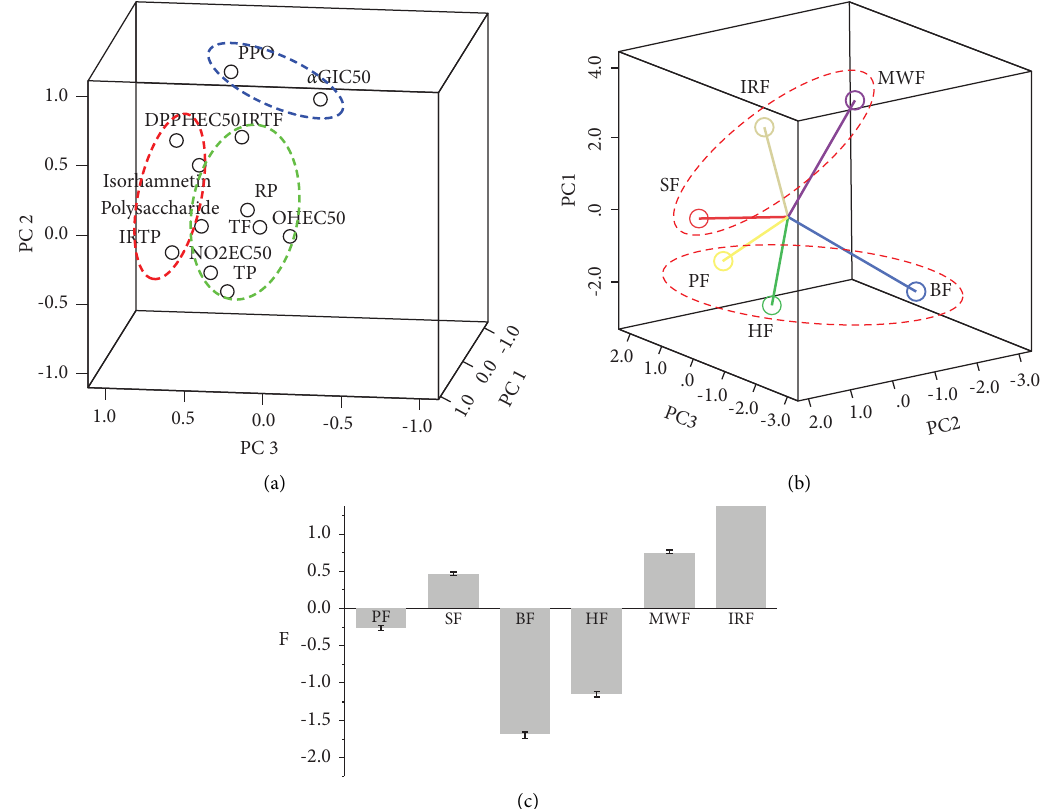
Figure 1: Principal component analysis (PCA) of sea buckthorn leaf tea prepared by diferent fxation methods. (a) Scores scatter plot of PCA, (b) loadings plot of PCA, and (c) scores of histogram of